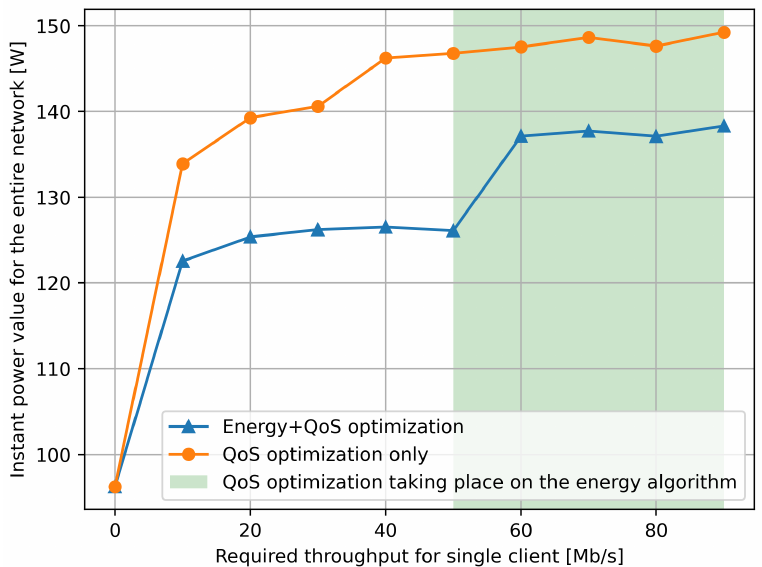
Figure 7. Instantaneous power consumption in the SDN switch part of the network, measured as a function of the clients’ data throughput towards the servers which are supporting the services. The power value is deduced from traffic measurements and from the power versus traffic data in Figure 2. We see that when the RL controller takes power into account, a power savings of the order of 15% occurs.